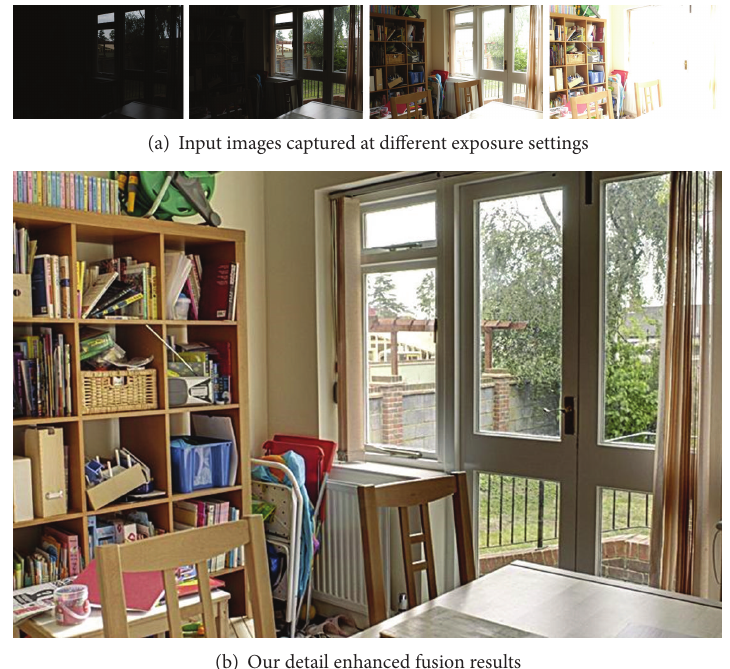
Figure 1: Results of proposed detail-enhanced exposure fusion framework using edge preserving filter.